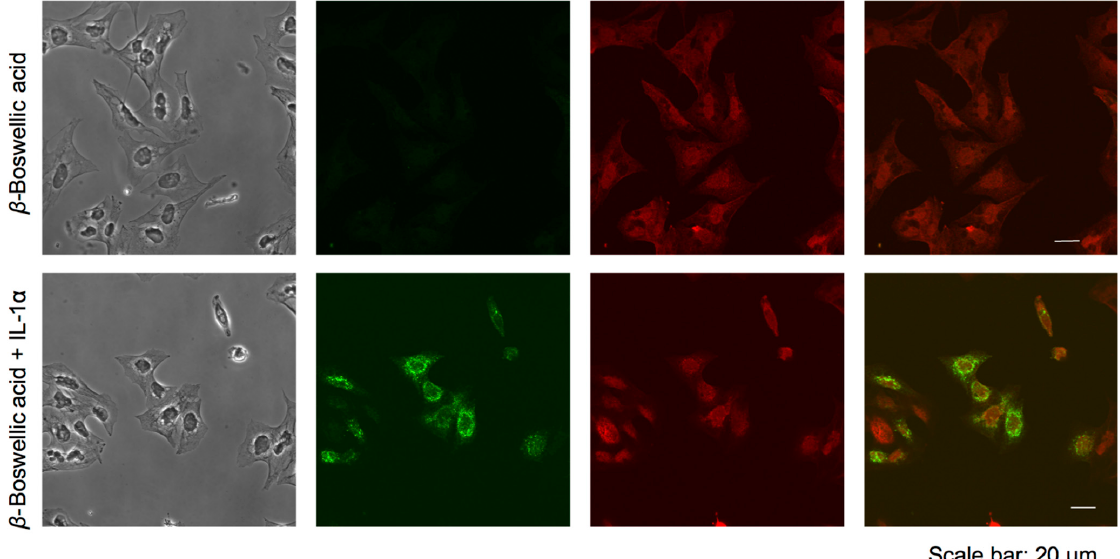
Figure 7. Effects of β -boswellic acid on the subcellular localization of ICAM-1 and calnexin. A549 cells were preincubated with (+) or without ( − ) β -boswellic acid for 1 h and then incubated with (+) or without ( − ) IL-1 α (0.25 ng/mL) for 6 h in the presence or absence of β -boswellic acid (100 µM). Cells were stained with the mouse anti-ICAM-1 antibody and Alexa Fluor ® 488-labeled anti-mouse IgG antibody or rabbit anti-calnexin and Alexa Fluor ® 594-labled anti-rabbit IgG antibody. Due to different acquirement conditions for clearer images, the subcellular localization of ICAM-1 and calnexin was observed, while fluorescent intensities between images were not directly compared. Data are representative of three independent experiments. Scale bars: 20 µm.